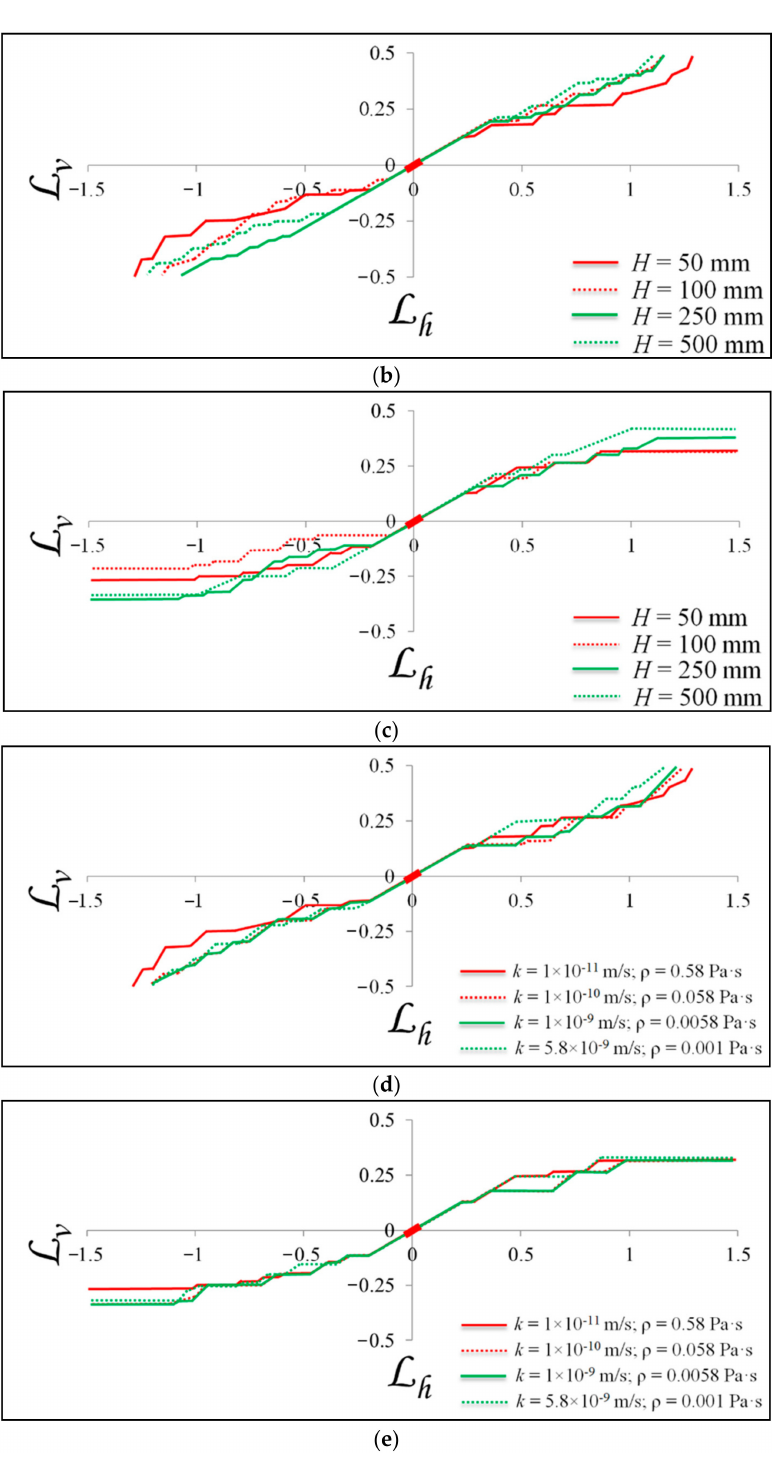
Figure 5. Modelling results of Sets 2 to 6 in Tables 6–8 [32]. The superimposition in each figure in ( a – e ) indicates that the modelling scenarios in each modelling set have similar dimensionless PHF trajectories: ( a ) Superimposed dimensionless PHF trajectories in Set 2 in Table 6; ( b ) Superimposed dimensionless PHF trajectories in Set 3 in Table 7; ( c ) Superimposed dimensionless PHF trajectories in Set 4 in Table 7; ( d ) Superimposed dimensionless PHF trajectories in Set 5 in Table 8; ( e ) Superimposed dimensionless PHF trajectories in Set 6 in Table